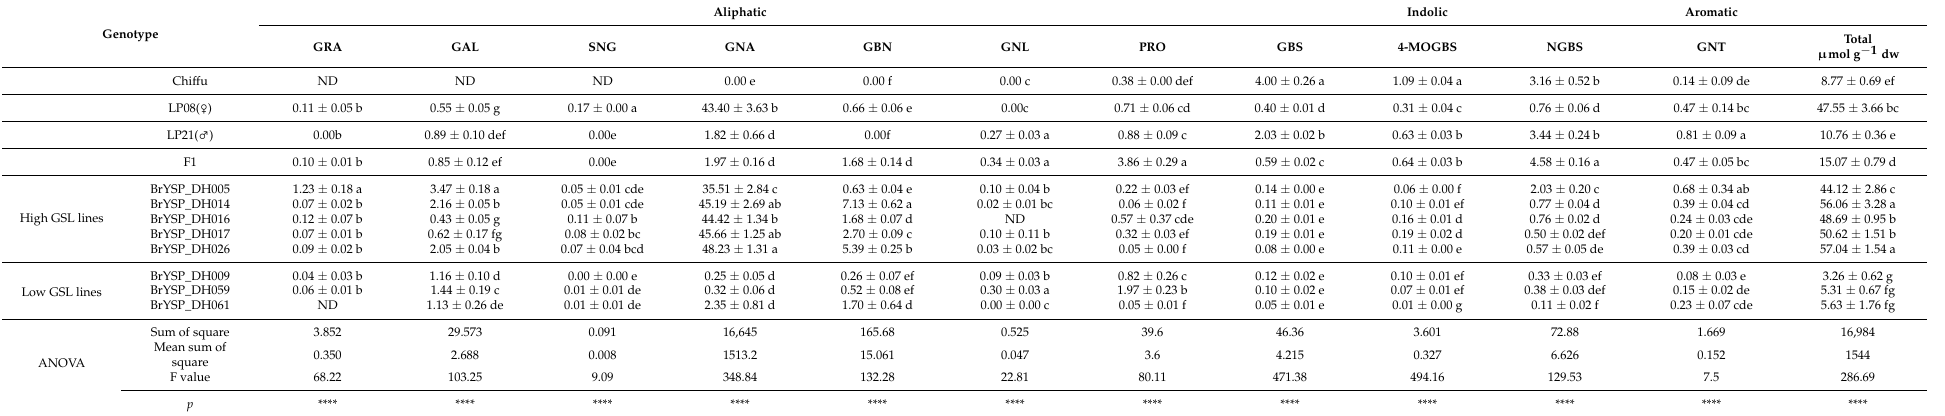
Table 1. Total and individual GSL content ( µ mol · g − 1 · dw) in leaves of Chiffu, a parent of LP08 and LP21, F1, and eight BrYSP_DH lines of Brassica rapa